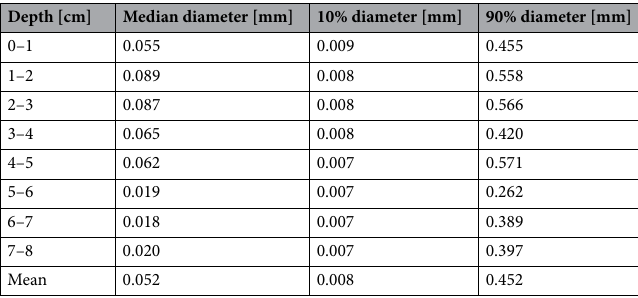
Table 1. Grain size distribution at the survey site.